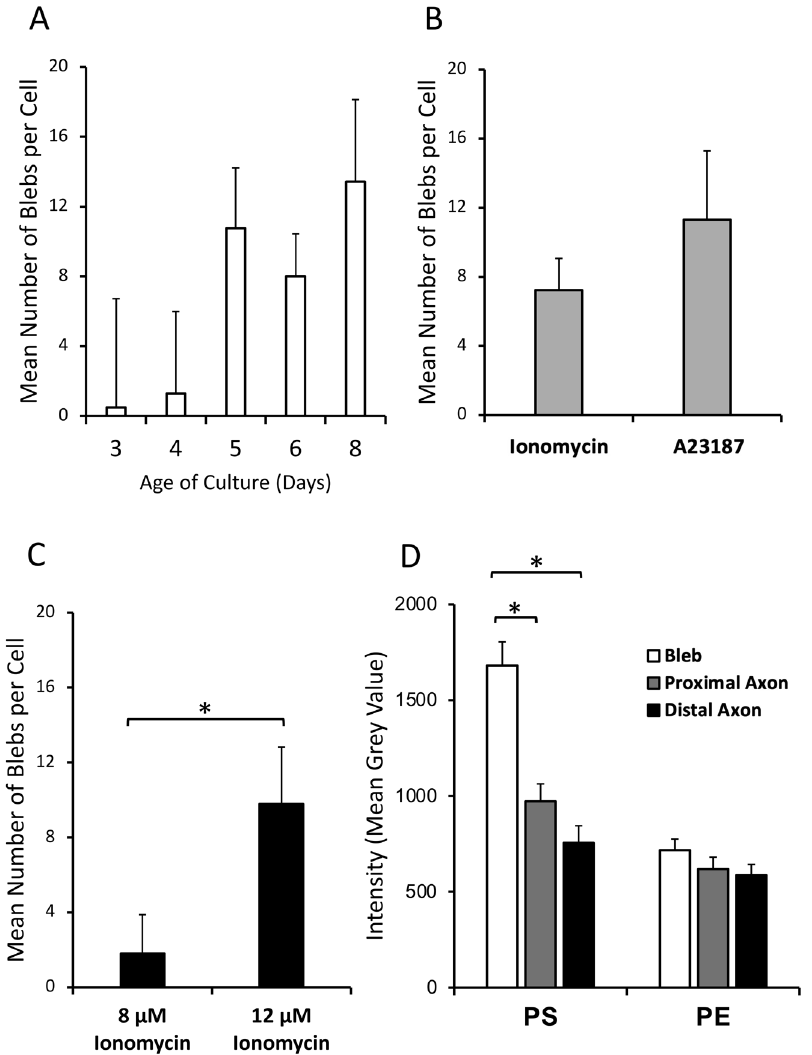
Fig. 3 Culture-time dependence, ionophore selectivity, and axonal region intensity of PS and PE externalization. A Mean number of blebs per cell after 2 h exposure to ionophore, by age of cell culture in days. B Mean number of blebs per cell after 2 h exposure to ionophores. C Mean number of blebs per cell after 2 h exposure to ionomycin. D Difference in intensity of bleb compared to adjacent axon regions. The intensity of 5 blebs from 10 cells each were measured, with three intensity measurements each for the bleb, proximal axon, and distal axon. * P <